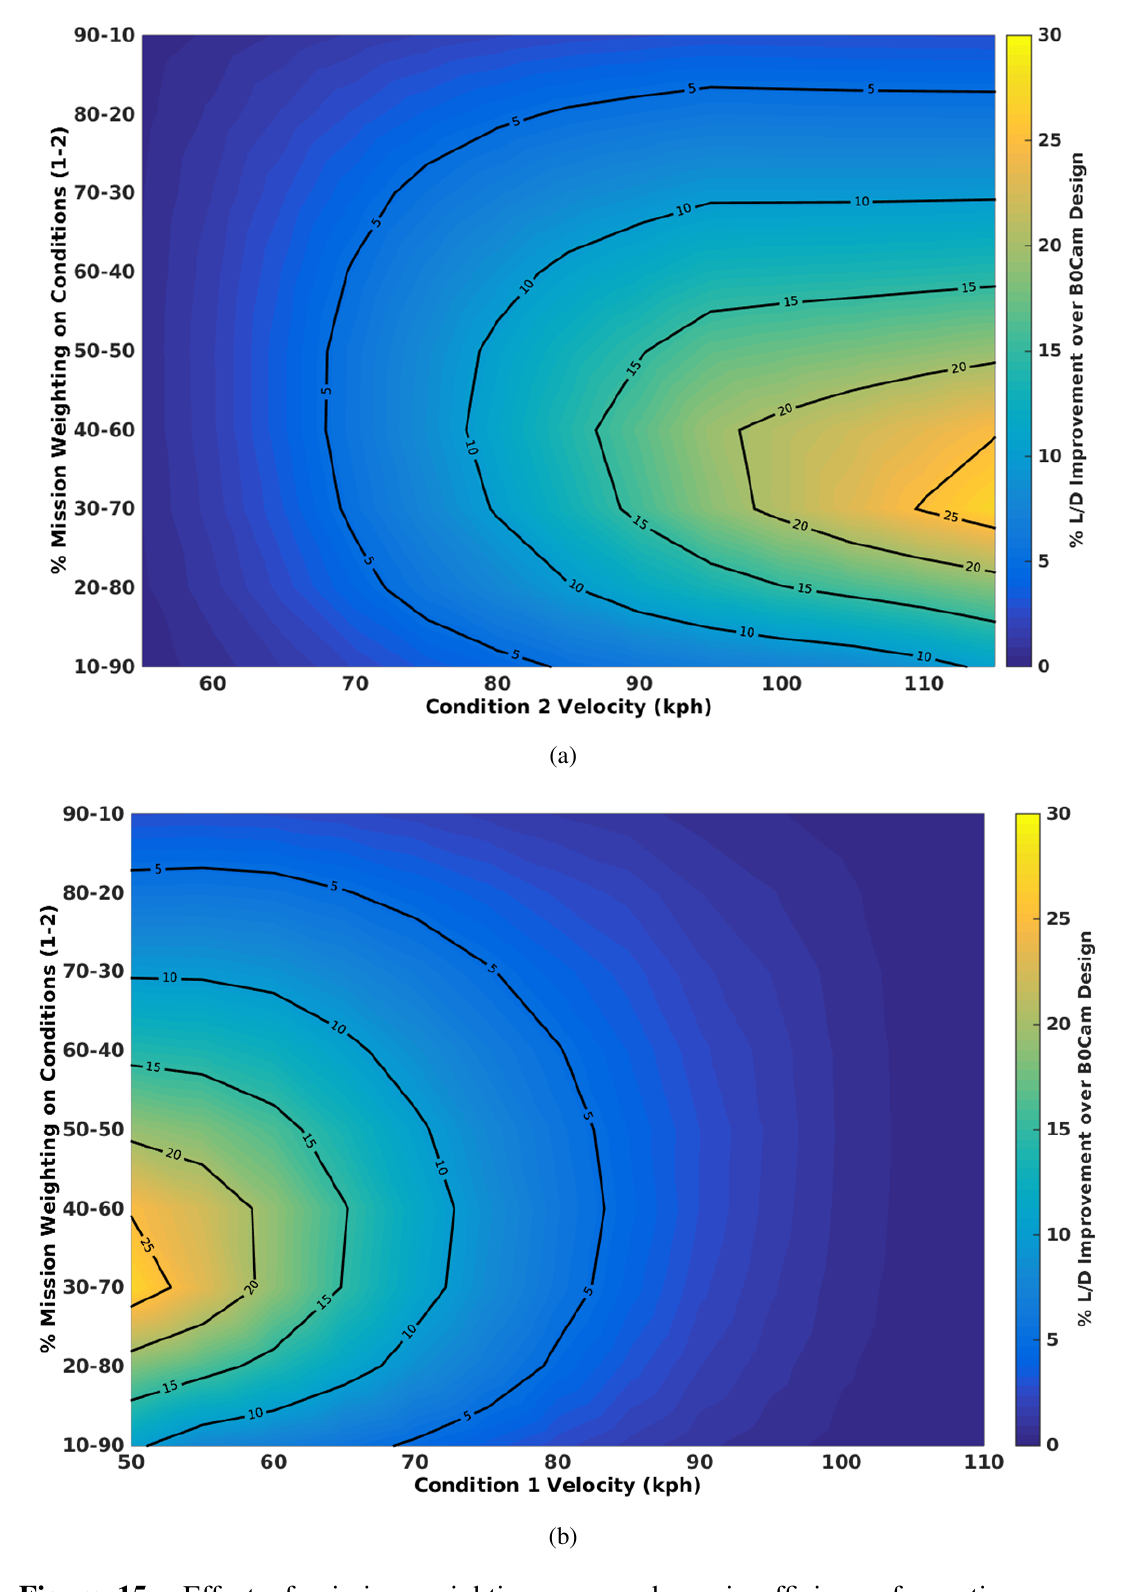
Figure 15. Effect of mission weighting on aerodynamic efficiency for optimum span with camber over variable speed ranges normalised to the baseline camber design. ( a ) Aerodynamic efficiency for low speed fixed at 50 kph; ( b ) aerodynamic efficiency for high speed fixed at 115